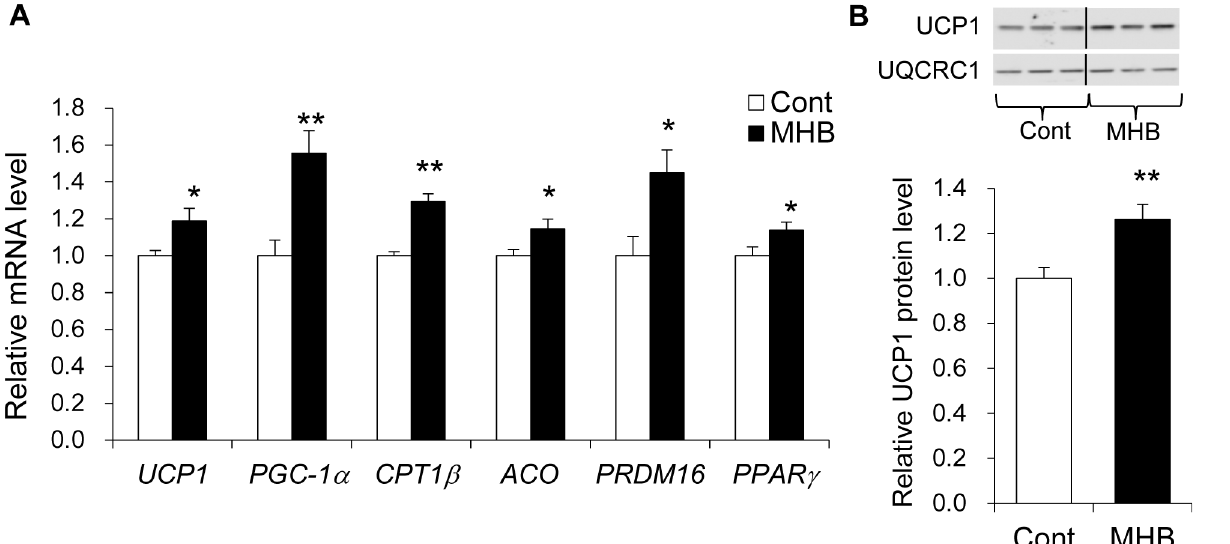
Fig 2. Measurement of mRNA expression levels and Immuno-blot analysis in the interscapular BAT of mice fed HFD supplemented with MHB. (A) mRNA expression levels in BAT. mRNA expression levels were normalized to the expression level of GAPDH as a reference. (B) Immuno-blot analysis of UCP1 in BAT mitochondria. Representative immuno-blots are shown on the histogram. Representative signals shown are from the same immuno-blot membrane. UCP1 protein level was normalized to the level of UQCRC1 protein as a reference. Data are presented as means ± SEM. n = 12 mice/group. * P < 0.05, ** P < 0.01 (by unpaired Student ’ s t -test). doi:10.1371/journal.pone.0131042.g002 (Mann-Whitney U test). This finding suggests that vagal afferent nerves are involved in MHB induced elevation of BAT-SNA.